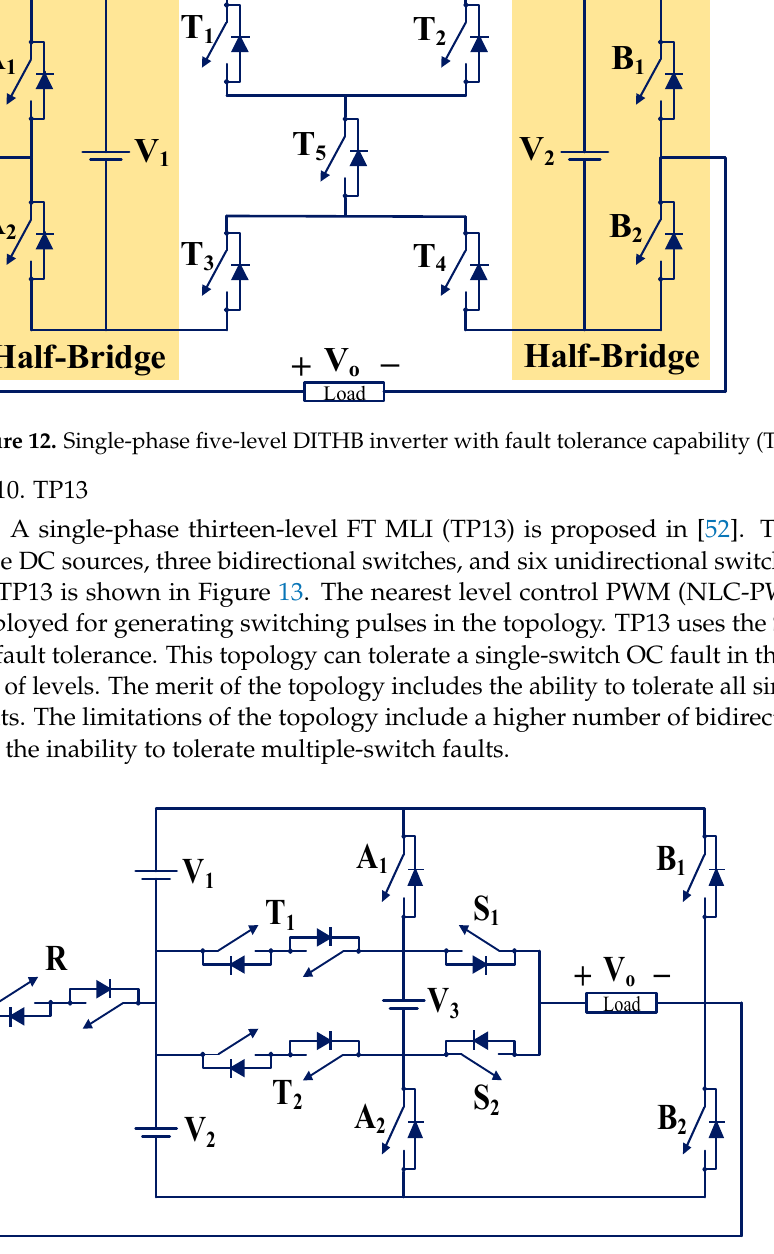
F c F d Figure 11. Single-phase five-level FT MLI (TP11) [51]. 3.1.9. TP12 A single-phase five-level FT MLI (TP12) is proposed in [37]. The authors named it DITHB, i.e., developed inverter with two half-bridges. TP12 comprises two DC sources and nine unidirectional switches. The circuit for TP12 is shown in Figure 12. The LS-SPWM scheme is employed for generating switching pulses in the topology. TP12 uses the IHR FT solution for fault tolerance. In faulty conditions, the topology can generate three levels for a single-switch OC fault. This topology can tolerate a single-switch OC fault in the circuit with a loss of levels. A higher number of conducting switches under healthy and faulty conditions is the limitation of the topology. The following are the merits of the to-